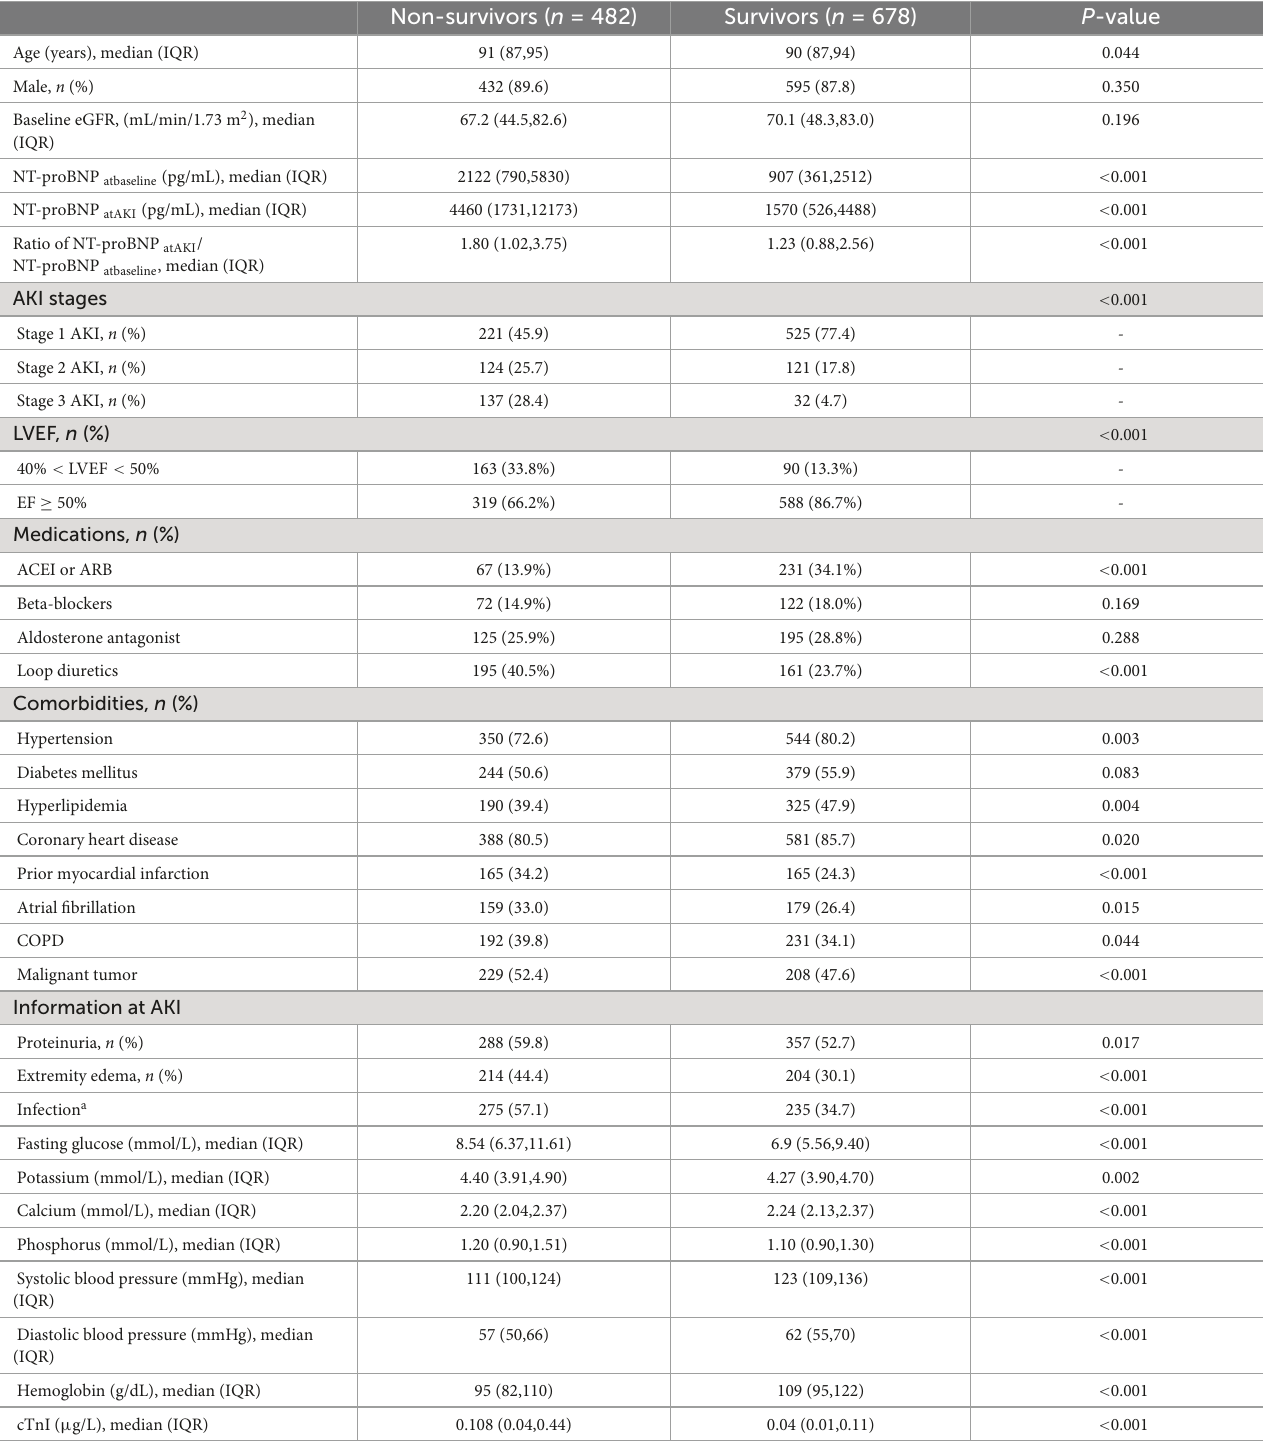
TABLE 1 Patient characteristics between elderly survivors and non-survivors. Non-survivors ( n = 482) Survivors ( n =